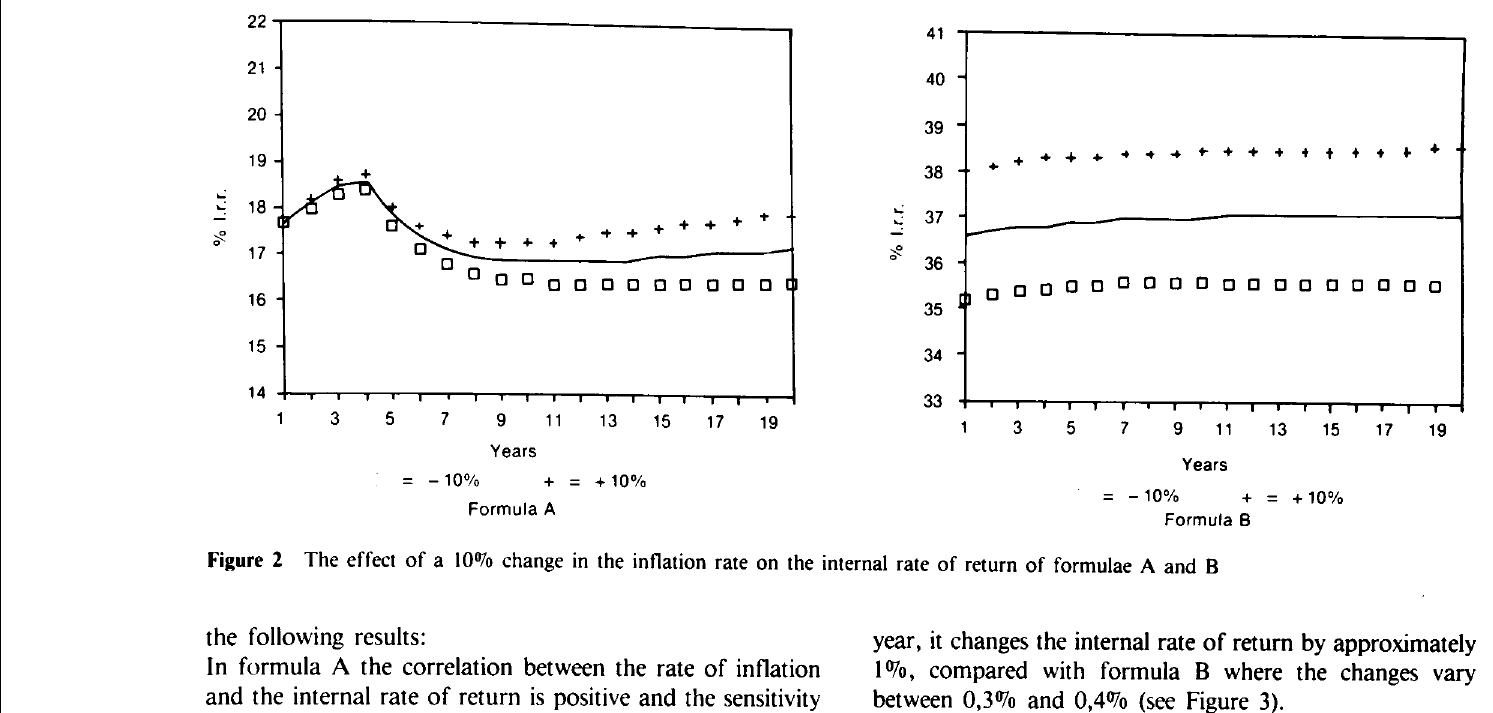
Figure 2 The effect of a 10% change in the inflation rate on the internal rate of return of formulae A and